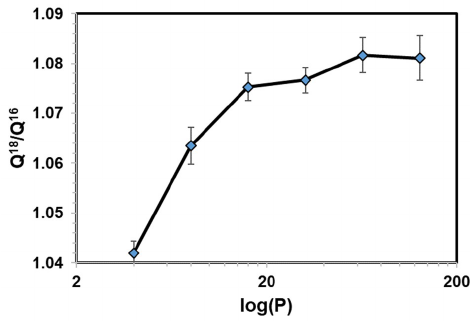
Figure 1. Computed ratio of 18 O and 16 O partition functions (Q 18 /Q 16 ) versus the number of quasi-particles P (= 4, 8, 16, 32, 64, and 128) used in path integral simulations of water in aqueous solution. Error bars were obtained from 10-block averages over the entire simulation.